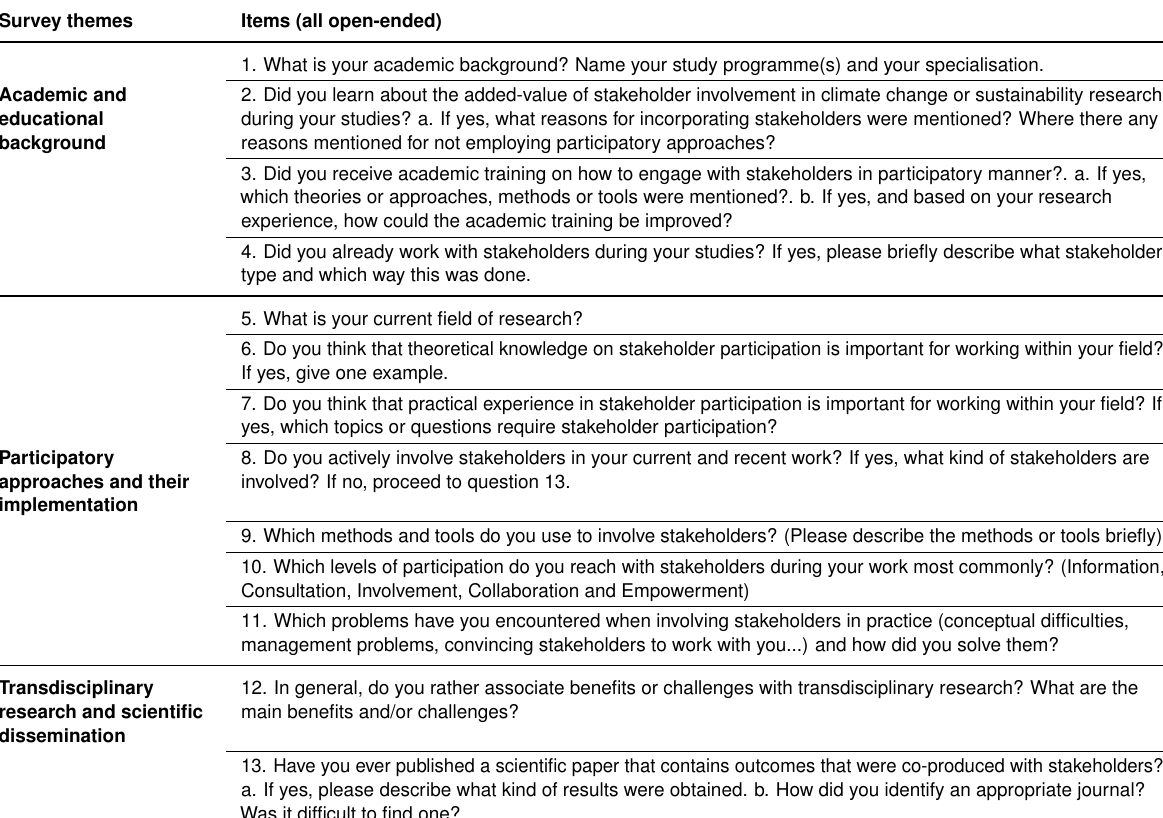
Table 1. Survey themes and items of the paper-based ex-ante